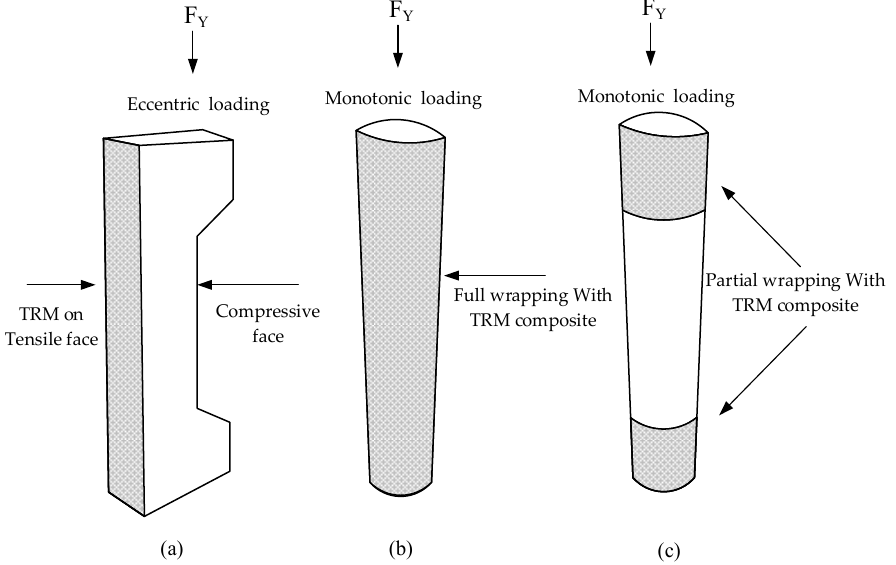
Figure 8. Different methods for strengthening columns: ( a ) strengthened column on tensile face; ( b ) entire wrapped column; and ( c ) partial.